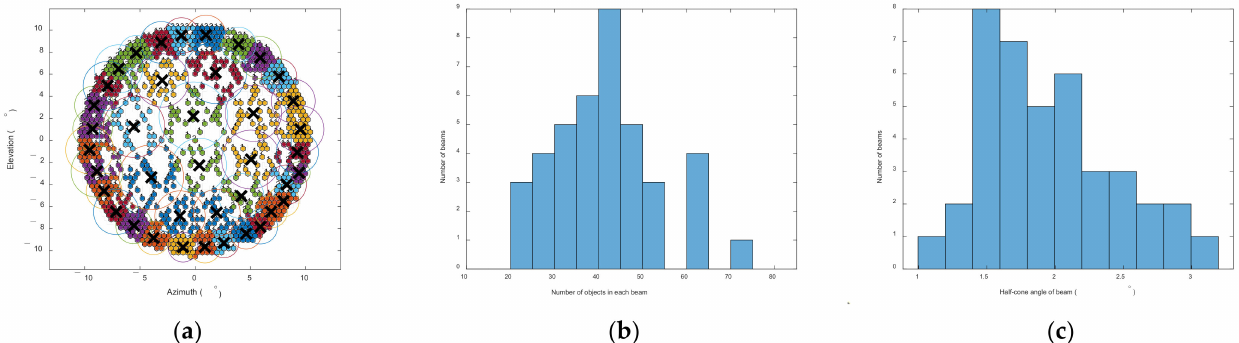
Figure 10. Optimization results of the beam allocation based on the modified K-means clustering when parameter α equals 0.5 and β equals 0.5: ( a ) Plot of the allocated 40 beams. The crossing indicates the geometrical center of each beam. The neighboring hexagonal cells in the same beam are marked with the same color; ( b ) Statistics of the beam occupation; ( c ) Statistics of the beam width.